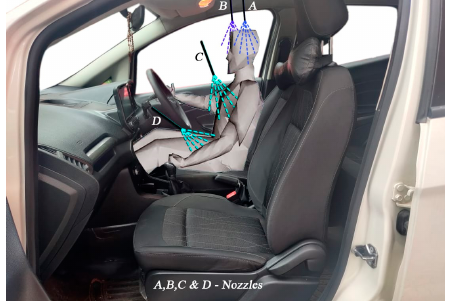
Figure 11. Conditioned air supply, A, B, C, & D are